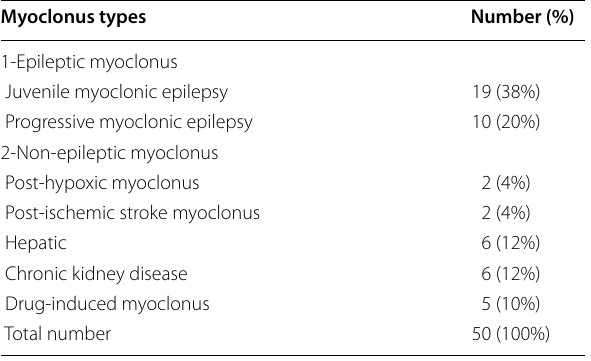
Table 1 Classifications of patients and types of myoclonus ( N 50) =